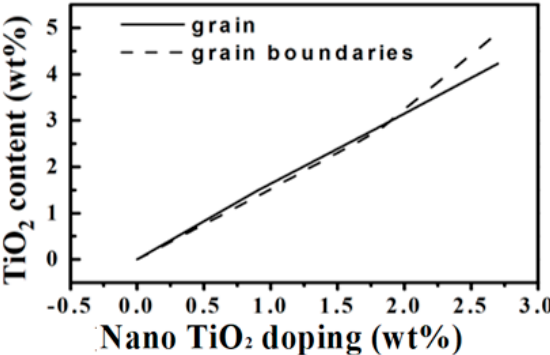
Figure 5. TiO 2 contents in grains and grain boundaries of the microwave-sintered 3Y-TZP ceramics sintered at 1250 °C.